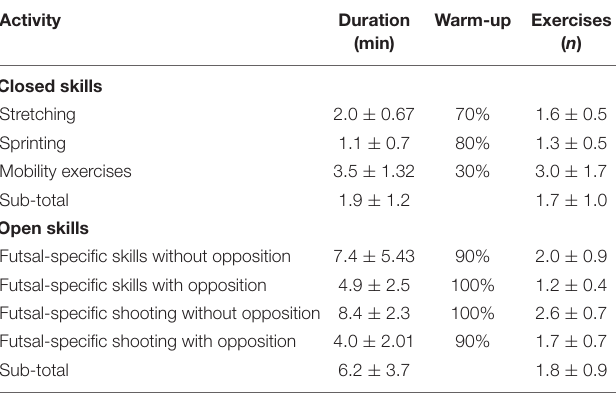
TABLE 1 | Description of task categories, duration, % of occurrence, and number of exercises in each category. Activity